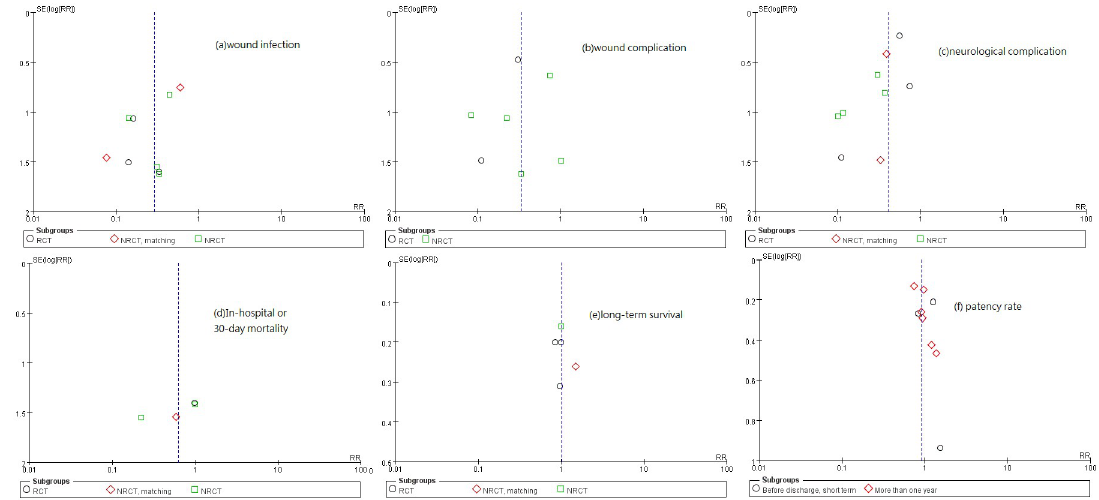
Fig 9. Funnel plot for publication bias: (a) wound infection, (b) wound complications, (c) neurological complications, (d) in- hospital or 30-day mortality, (e) long-term survival, and (f) patency rate.